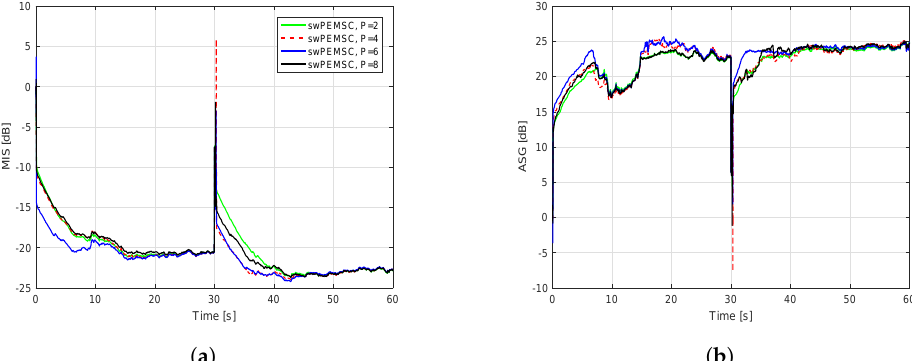
Figure 9. Performance of the proposed method with P ∈ [ 2,4,6,8 ] , speech input, feedback path changes from free-field ( F 1 ) to telephone-near ( F 2 ): ( a ) MIS; ( b ) ASG.